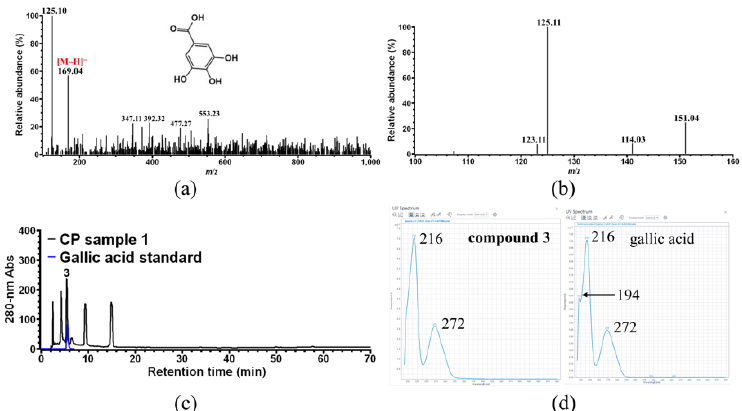
Figure 4. Identification of CP compound 3 . ( a ) MS analysis of compound 3 ; ( b ) MS/MS analysis of the ion with m / z 169.04 obtained in ( a ); ( c ) HPLC overlay chromatogram of CP sample 1 and commercial gallic acid standard; ( d ) UV ‐ vis spectrum analysis of compound 3 and gallic acid standard.